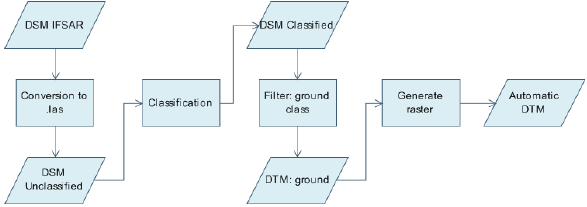
Figure 7. Work flow for this study Detailed work flow for filtering by classification process describes in Figure 8.